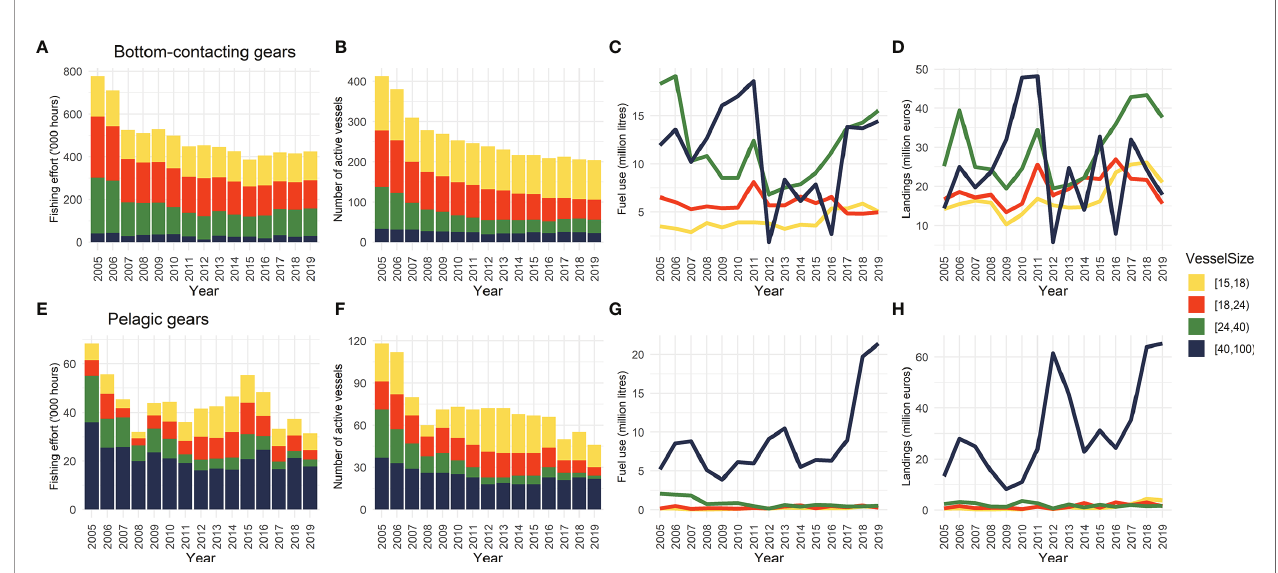
FIGURE 2 | Time development for large VMS-equipped Danish vessels using bottom contact gears (top panel) or pelagic gears (bottom panel) of effective fi shing effort (A, E) , number of active vessels (B, F) , fuel use (C, G) , and landed value (D, H) during the period 2005-2019. The plots are sectored per vessel size category in metre (15-18m, 18-24m, 24-40m, >40m). Effective effort is deduced from the VMS positioning analysis coupled to